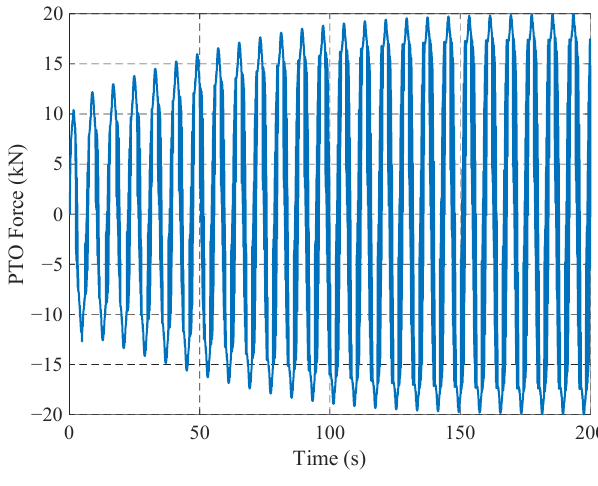
Figure 11. The PTO force of hydraulic PTO.